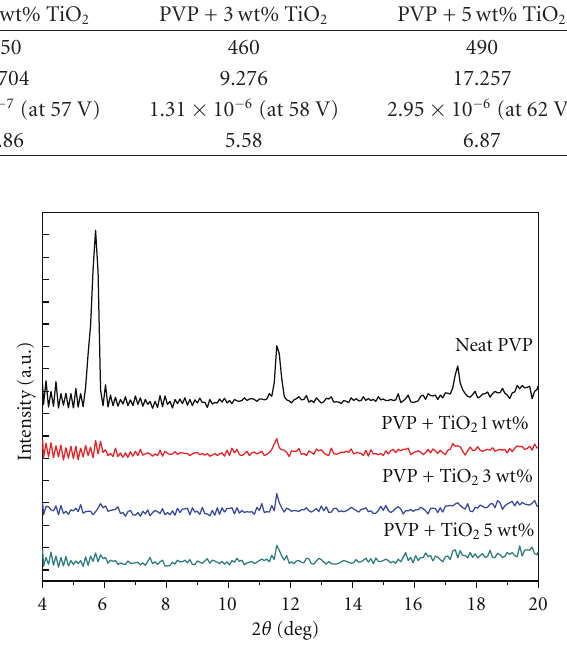
Figure 6: X-ray di ff raction patterns of pentacene films were deposited on NC-films with various doped content: (a) neat PVP 9wt%(cross-linked); (b) PVP+TiO 2 1wt%; (c) PVP+TiO 2 3wt%; (d) PVP+TiO 2